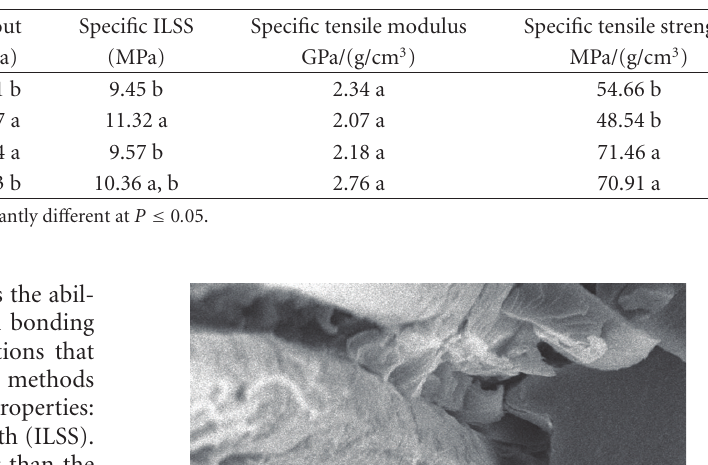
Table 4: Interface and tensile strengths of enzyme-retted flax fiber composites ∗ .